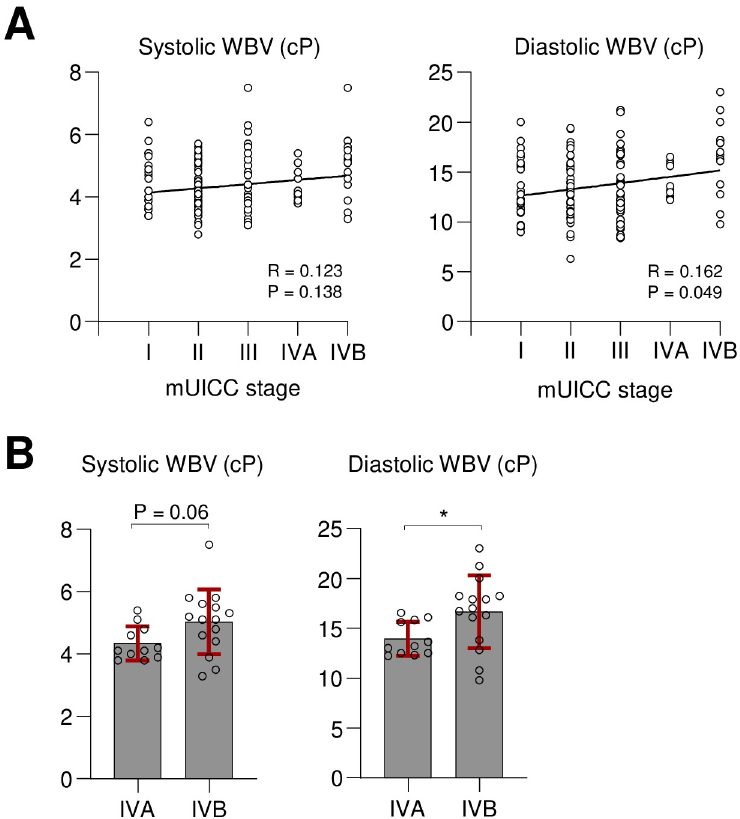
Fig 1. (A) Correlation between systolic WBV (left) or diastolic WBV (right) and HCC stage (mUICC stage) (n = 148) based on Spearman’s rank correlation test. (B) Comparison of systolic WBV (left) or diastolic WBV (right) between patients with stage IVA (n = 11) and stage IVB (n = 15) using Mann-Whitney U test. � P <